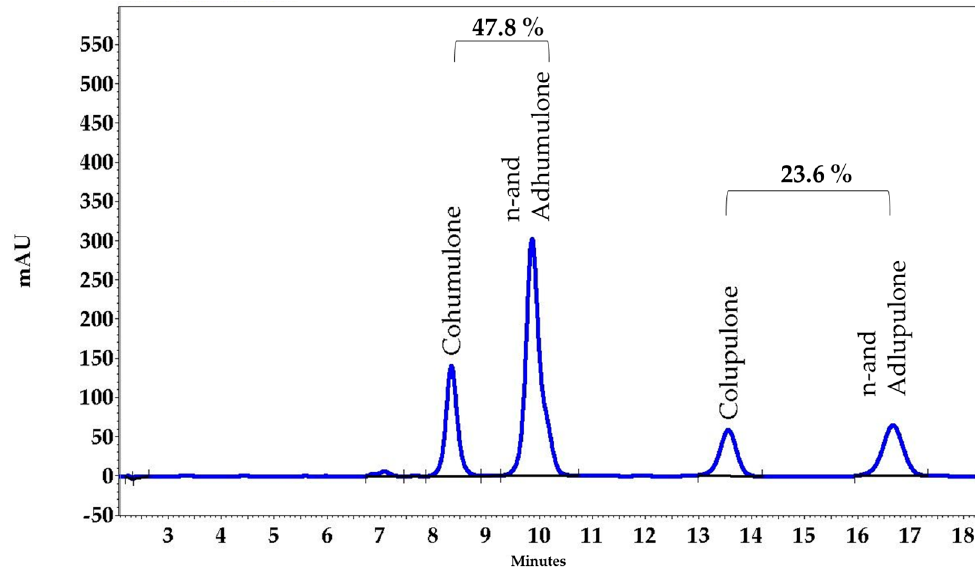
Figure 7. HPLC fingerprint of the HL extract.